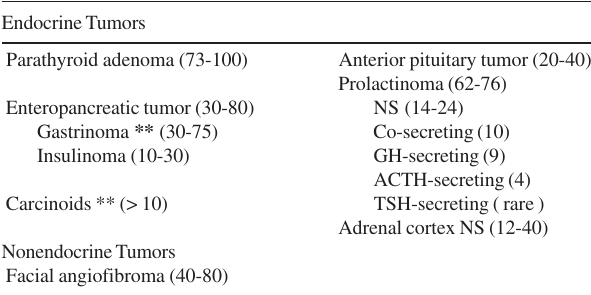
Table 1 - Prevalence (%) of clinical features in MEN1 disease* Endocrine